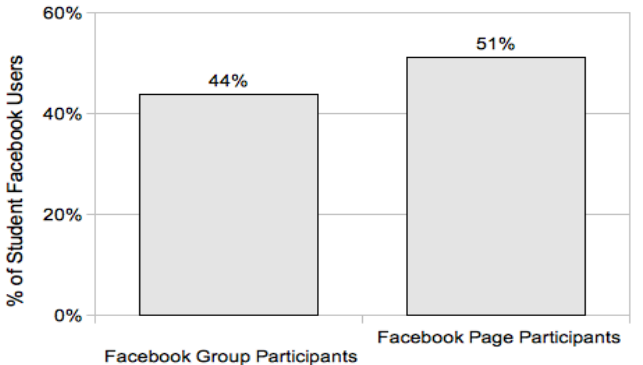
Figure 13. Participants in Facebook groups and Facebook pages. Note that data are